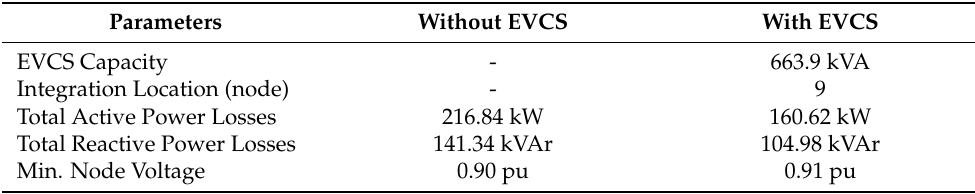
Table 2. Comparison of parameters with and without EVCS.